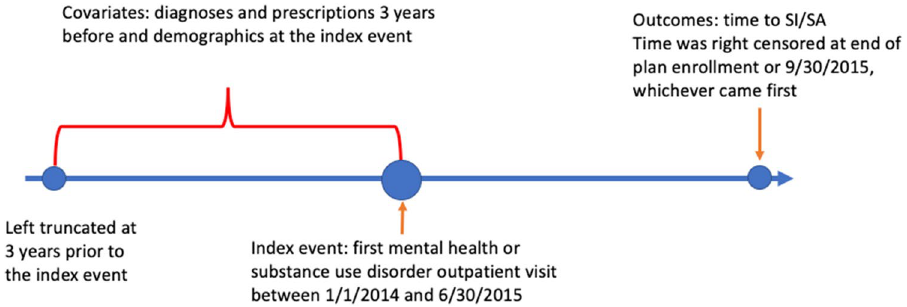
Figure 1. Summary of the study